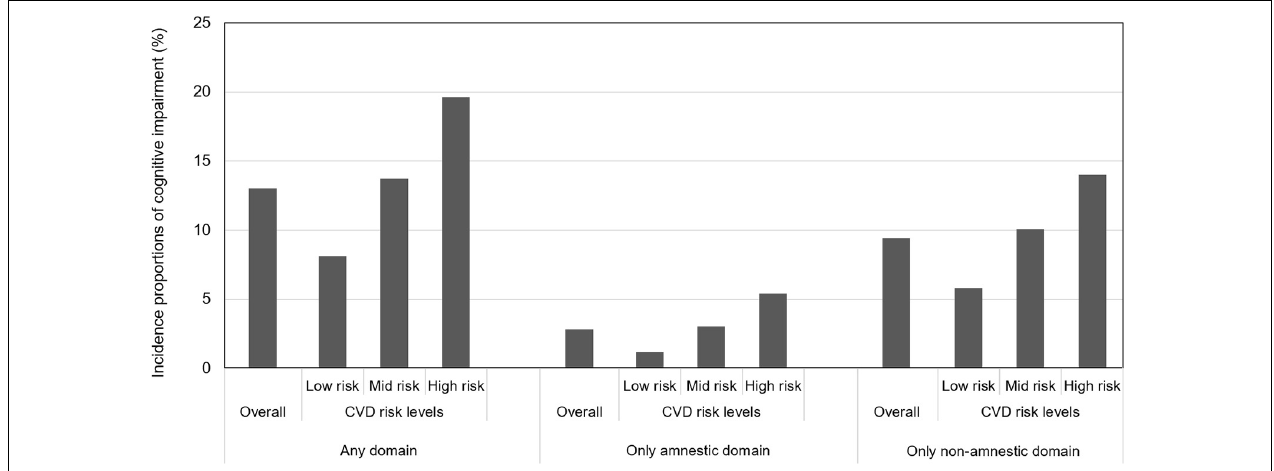
FIGURE 2 | Incidence proportions of cognitive impairment according to baseline CVD risk